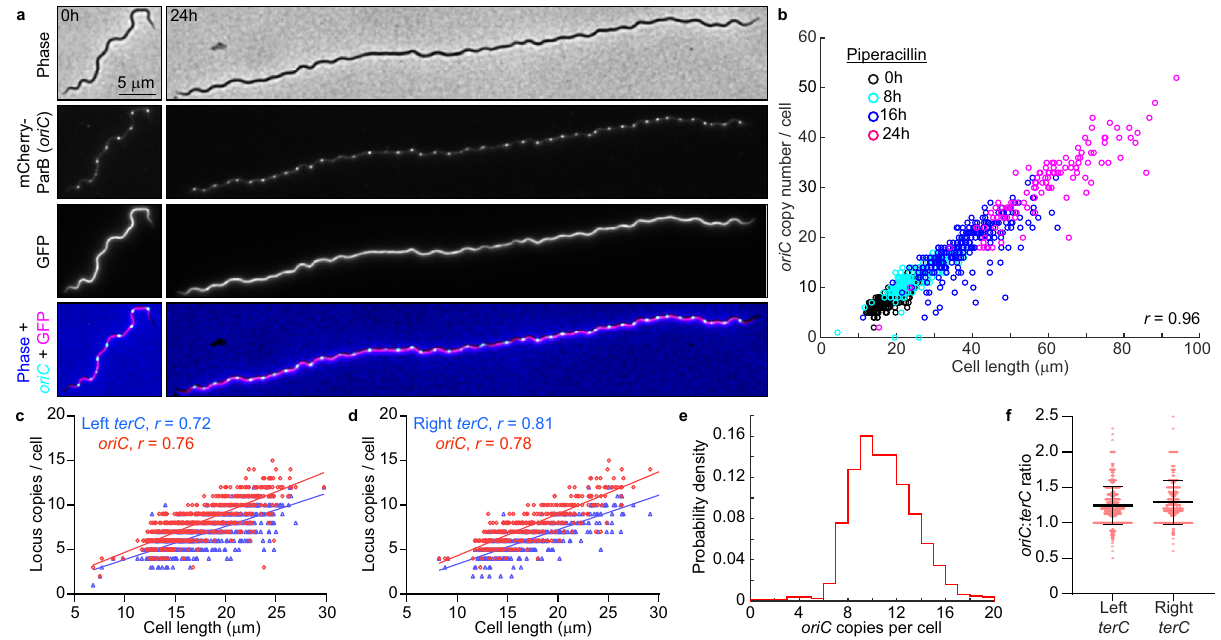
30 Cell length ( (cid:2) m) Fig. 4 | B. burgdorferi chromosome copy numbers correlate with cell length. CJW_Bb527. r , Pearson ’ s correlation coef fi cient. e Histogram of oriC copy numbers a Images of cells of strain CJW_Bb474 before (0h) or after 24h of exposure to per cell in exponentially growing cultures of strain CJW_Bb379. f Plot showing the piperacillin. b Correlation of oriC copy number per cell with cell length in strains oriC : terC ratios calculated in single cells from exponentially growing cultures of CJW_Bb474 and CJW_Bb379 following the indicated durations of piperacillin strainsCJW_Bb201andCJW_Bb527,following fl uorescentspotdetection.Blacklines treatment. r , Pearson ’ s correlation coef fi cient. c Correlations of oriC and terC copy depict means ± standard deviations. Source data for panels b-f are provided as a number per cell with cell length in exponentially growing cultures of strain SourceData fi le.Thenumbers( n )ofcellsanalyzedandthenumberofreplicatesare CJW_Bb201. r ,Pearson ’ scorrelationcoef fi cient. d Correlationsof oriC and terC copy provided in Supplementary Data number per cell with cell length in exponentially growing cultures of strain